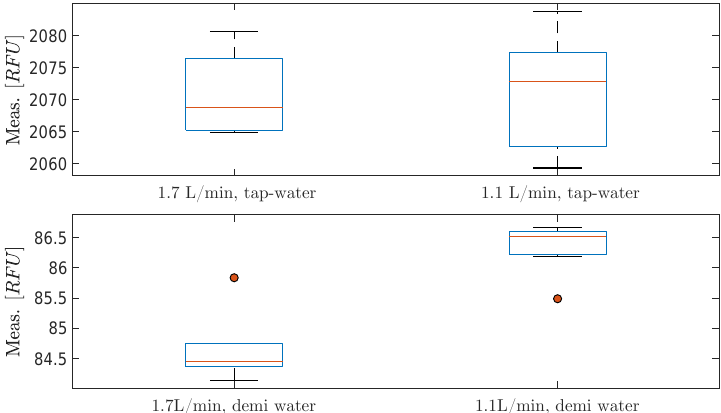
Figure 12. Boxplots for each type of water with different flow rates.